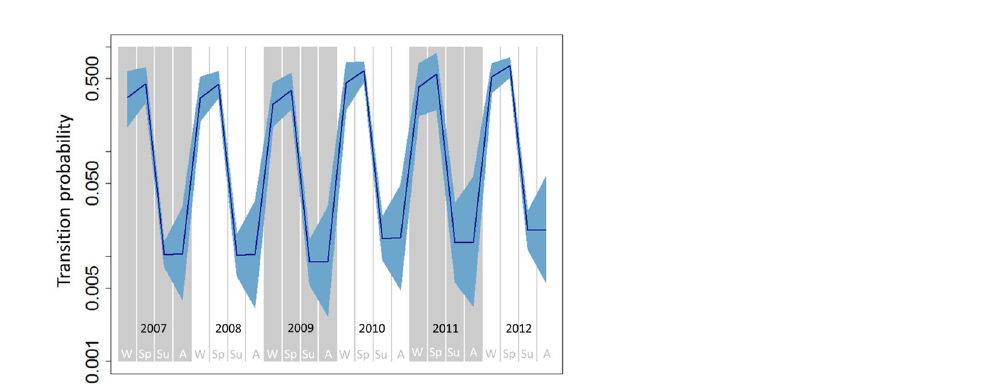
Figure 2. Temporal dynamic of the probability that an uninfected badger becomes infected between two capture sessions. Blue shading indicates 95% confidence intervals. The y-axis is on the log-scale. W: winter; Sp: spring; Su: summer; A: